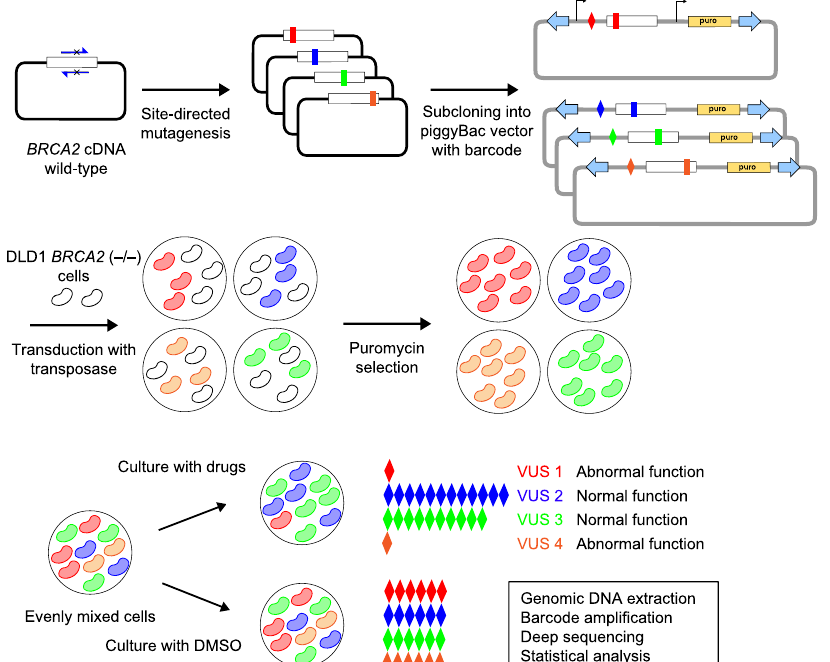
Fig. 1 Schematic representation of the MANO-B method. BRCA2 variants of interest were generated by site-directed mutagenesis and subcloned into the piggyBac transposon vector with a unique barcode sequence, followed by sequence veri fi cation. DLD1 BRCA2 ( − / − ) cells were individually cotransfected with the BRCA2 constructs and transposase expression vector. After puromycin selection of stable transfectants, equal numbers of DLD1 cells were mixed and cultured with PARP inhibitors, CBDCA, or DMSO for 12 days. The barcode sequences were ampli fi ed by PCR with genomic DNA extracted from the cell mixture and deep sequenced to quantify their relative abundances. The ratio of each barcode abundance was normalized to that of the DMSO-treated control. The relative viability data were analyzed by Bayesian inference, and the pathogenicity of each variant was then classi fi